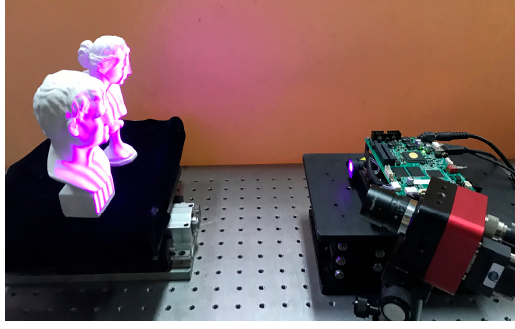
Figure 7. Setup used in the experiments.